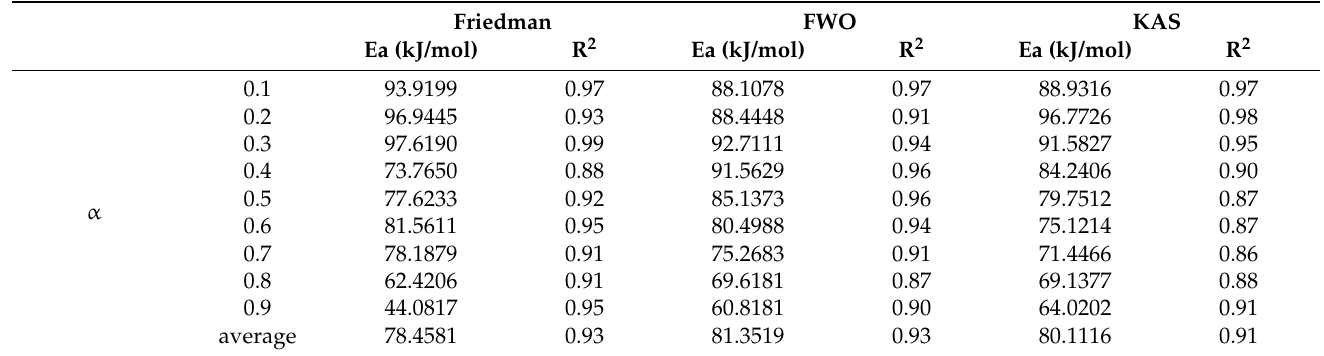
Table 1. Ea and R 2 of three model-free methods at different conversion rates in the first stage of pyrolysis kinetics of battery materials.